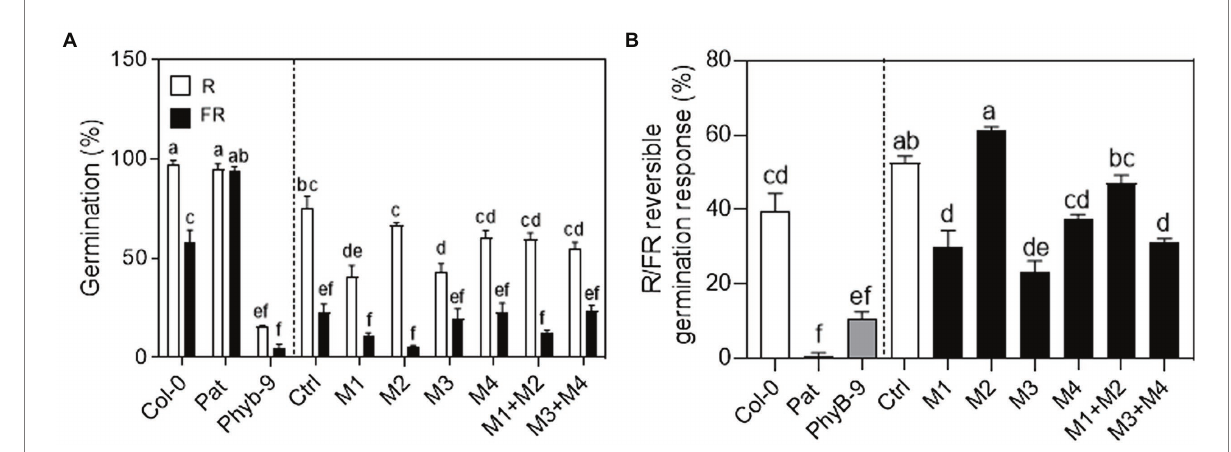
FIGURE 4 Functional variation of PHYB polymorphisms in seed germination. (A) Germination (%) with an R or FR saturated pulse and then incubated in darkness for 4 days at 25 ° C before germination was counted. The seeds were imbibed in water for 3 days at 7 ° C before the light pulse. (B) R/FR reversible response (%) calculated as the germination with a red pulse minus the germination with a far-red pulse. Mean ± SE ( n = 6). Significant differences between means are shown with different letters by Two-way ANOVA (A) or One-way ANOVA (B) followed by Bonferroni post-test ( p <